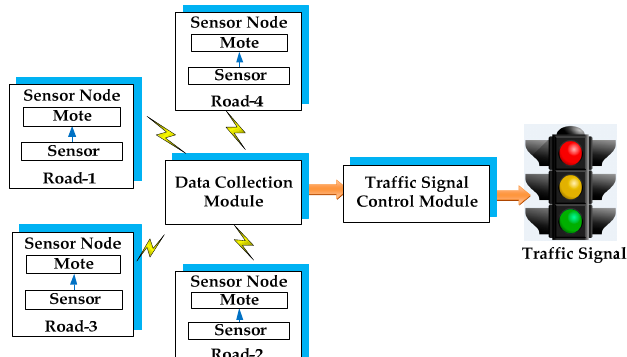
Figure 2. Schematic of a traffic management centre.